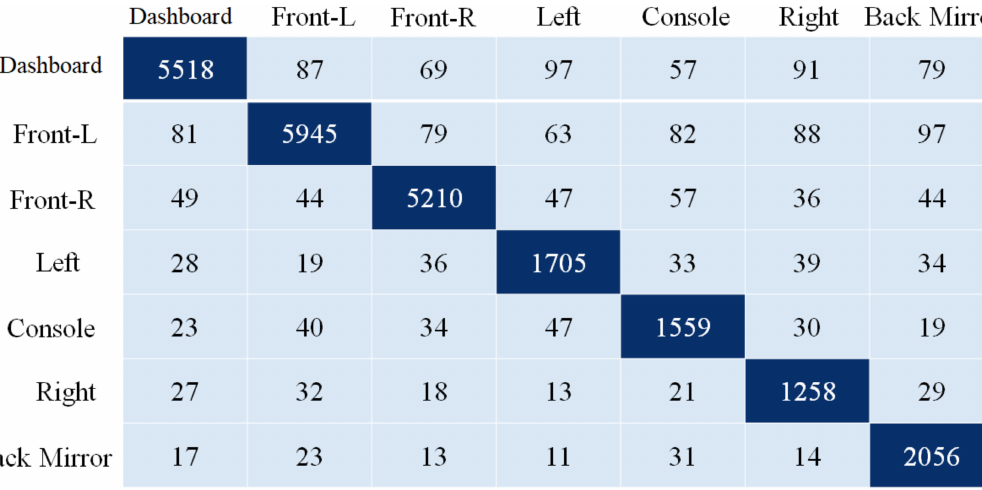
Figure 13. Confusion matrix of the proposed driver gaze detection technique.